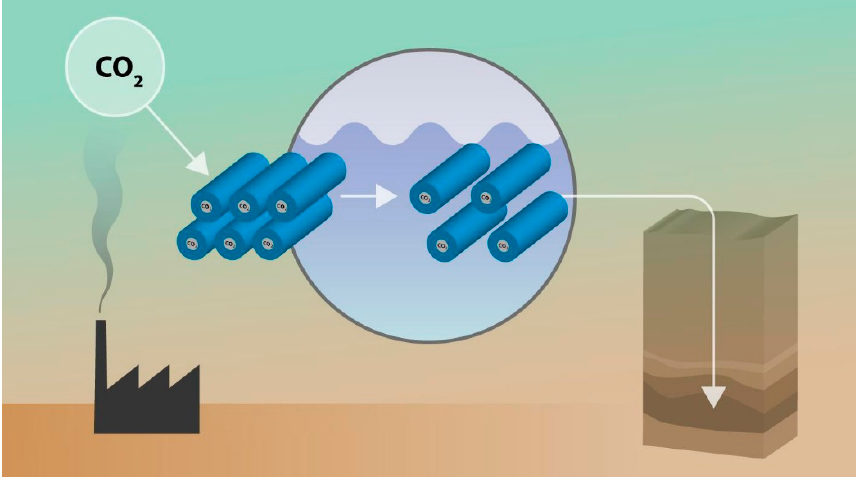
Figure 1. CO 2 capture, transport, and storage using liquid crystal technology. Illustration by Eivind Vetlesen. Poly(ethylene oxide) ‐ poly(propylene oxide) ‐ poly(ethylene oxide) (PEO ‐ PPO ‐ PEO) are